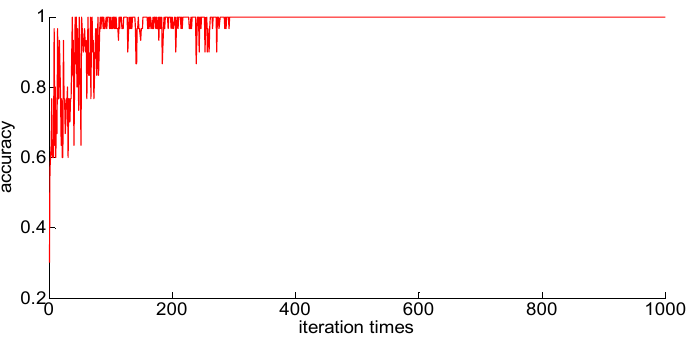
Figure 18. One hundred twenty-five training samples of the neural network.